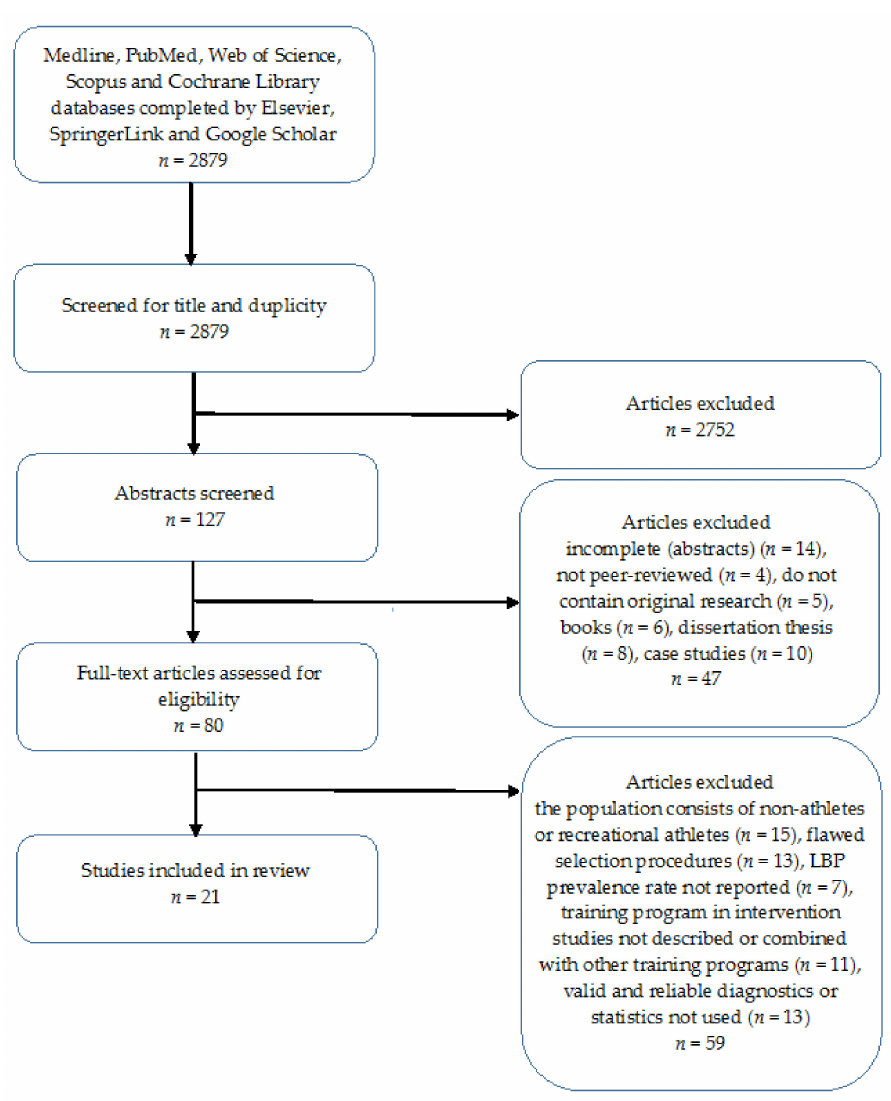
Figure 1. Flow chart of study